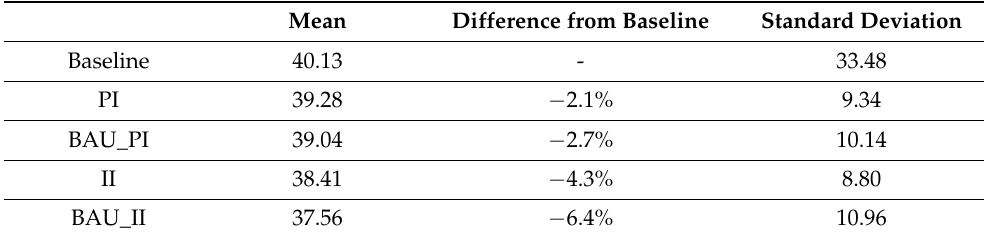
Table 6. Description of the electricity prices (£/MWh) of each scenario, showing that island renewable capacity would not reduce average prices as much as offshore wind, but would have a stabilizing effect on the volatility of prices.